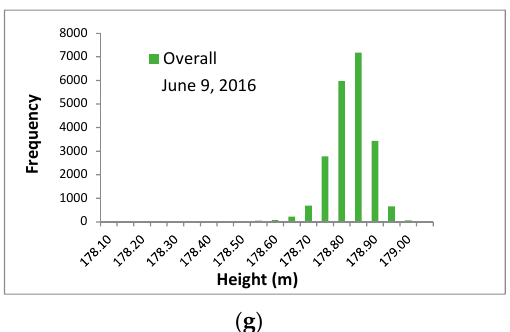
Figure 4. Histograms of the point distribution of a typical 3D column in the crop field at di ff erent crop growth stages. The distribution of overall points, bare ground points, and plant points are represented by black, brown, and green bars. X-axis is the elevation of points and Y-axis is the frequency of points. ( a ) The histogram of points distribution for bare ground points in October 2015. ( b , c ) The histogram of points distribution in the early growth stage of winter wheat (BBCH ≈ 31) on 16 May 2016. ( d , e ) The histogram of points distribution in the middle growth stage of winter wheat (BBCH ≈ 65) on 31 May 2016. ( f , g ) The histogram of points distribution in the late growth stage of winter wheat (BBCH ≈ 83) on 9 June 2016.